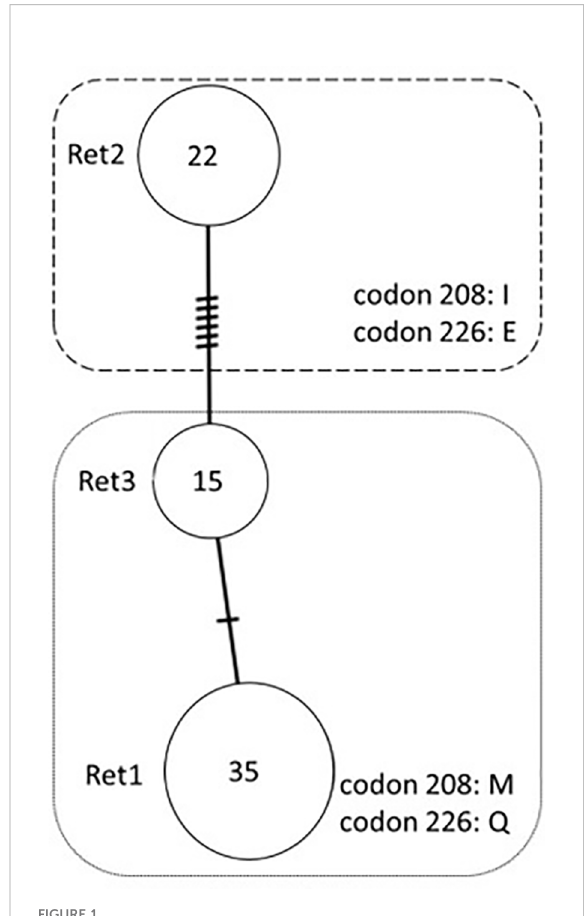
FIGURE 1 Median-joining network of PRNP haplotypes in Eld ’ s deer ( Rucervus eldii thamin ). Each circle represents a distinct haplotype; each hatch mark on the branches separating circles represents a mutation. The size of each circle is proportional to the number of chromosomes carrying the haplotype, which is also listed within the circle. The designation for each haplotype is listed beside the circle. There were two non-synonymous mutations, for which encoded amino acids are shown within the dotted boxes. The box outlined by small dots includes the two haplotypes that encode PrP variant 208M;226Q (Ret1 and Ret3). The box outlined by dashes includes the single haplotype that encodes PrP variant 208I;226E